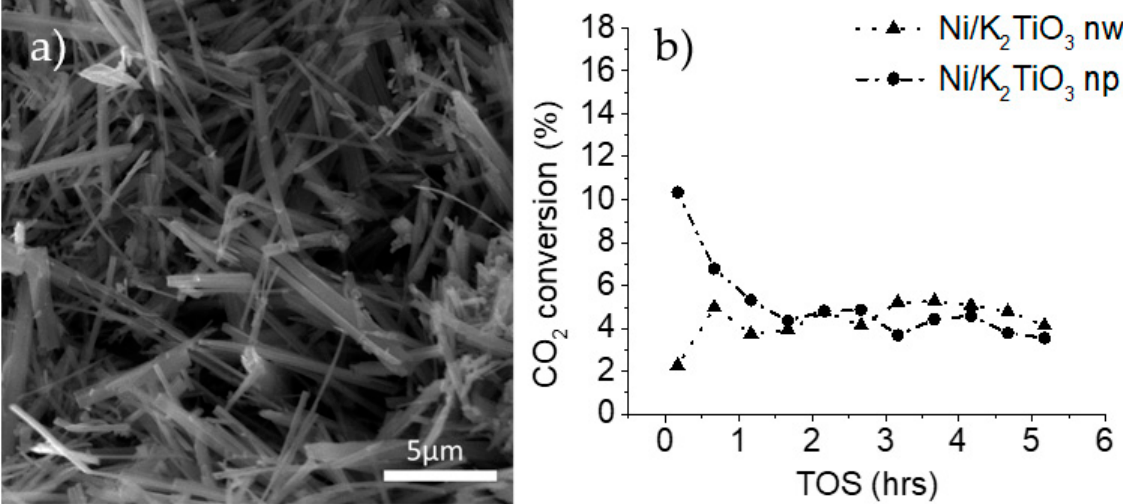
Figure 1. ( a ) SEM image of potassium titanate nanowires used as the support for nickel, ( b ) CO 2 conversion during dry methane reforming using potassium titanate as the support (750 °C, gas hourly space velocity (GHSV) of 30,000 mlgr − 1 h − 1 , feed ratio of methane to carbon dioxide of 2).